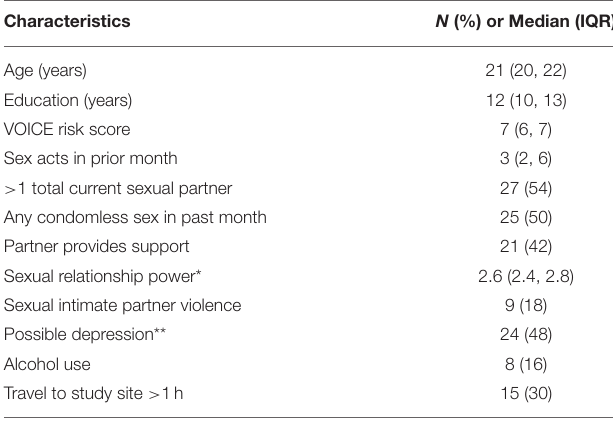
TABLE 2 | Baseline demographic characteristics of study participants ( n =